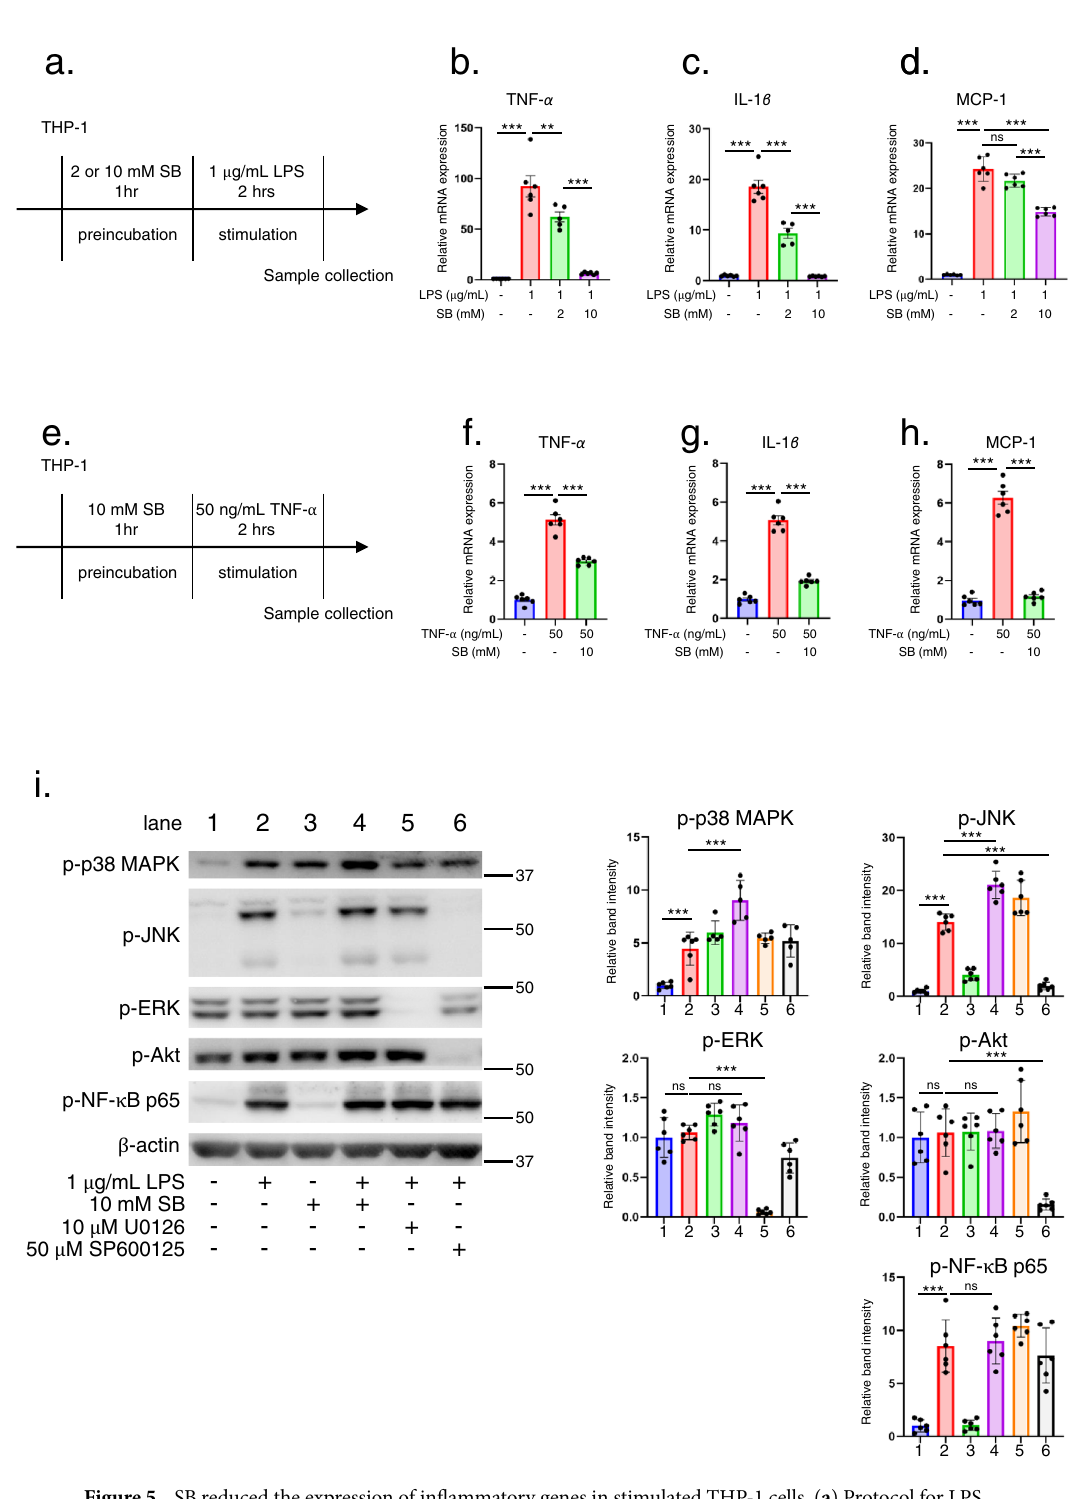
Figure 5. SB reduced the expression of inflammatory genes in stimulated THP-1 cells. ( a ) Protocol for LPS stimulation in THP-1 cells with or without SB preincubation. RT-PCR analysis of ( b ) TNF-α , ( c ) IL-1β , and ( d ) MCP-1 . mRNA levels were adjusted to that of GAPDH (n = 5–10 each). ( e ) Protocol for TNF-α stimulation in THP-1 cells with or without SB preincubation. RT-PCR analysis of ( f ) TNF-α , ( g ) IL-1β , and ( h ) MCP-1. mRNA levels were adjusted to that of GAPDH (n = 6 each). ( i ) Immunoblotting (left panel) and quantification (right panel) of phosphorylated signal transduction molecules (n = 5–6). Band intensities were quantified using ImageJ software and adjusted to the intensity of the internal control molecule, β-actin. LPS (lane 2) significantly increased phospho-JNK and phospho- NF-κB p65 compared with the control (lane 1). SB did not decrease the phosphorylation of either molecule (lane 4). For comparison, the MEK inhibitor U0126 significantly decreased phospho-ERK levels (lane 5), while the JNK inhibitor SP600125 significantly decreased phospho-JNK (lane 6) and phospho-Akt (lane 6) levels. * p < 0.05; ** p < 0.01; *** p < 0.001; ns, not significant. Each bar represents mean ± SEM. LPS, lipopolysaccharide; SB, sodium